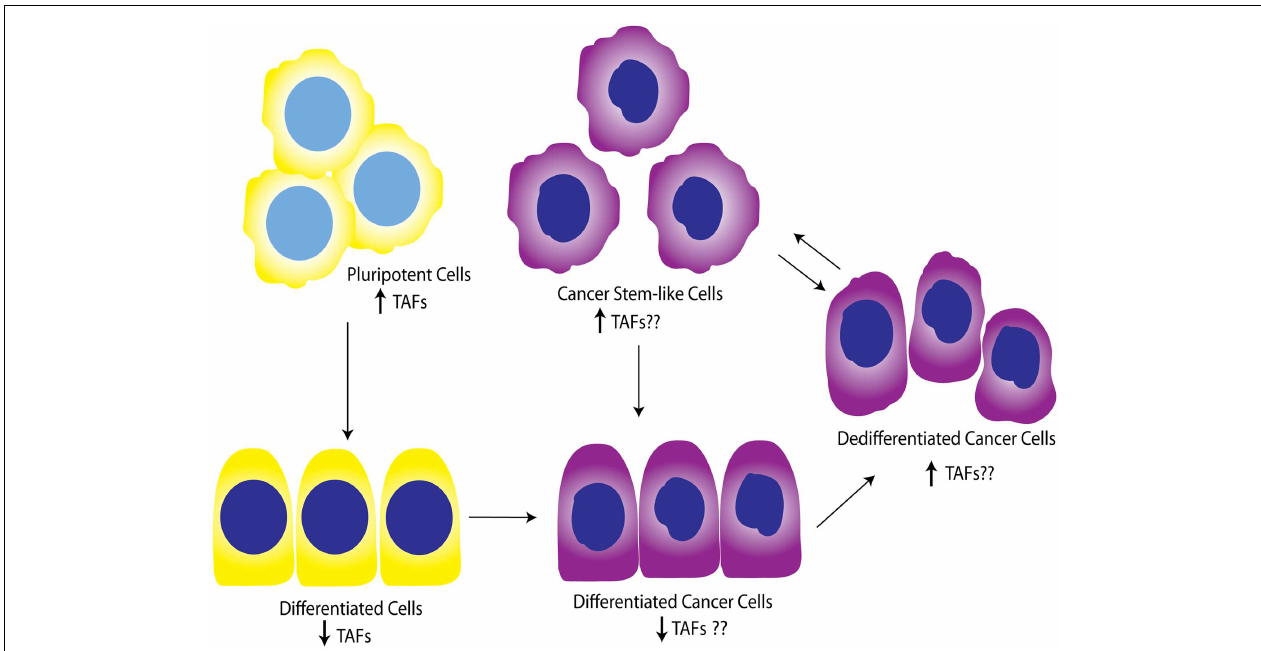
FIGURE 5 |Working model forTAF involvement in differentiation during development and tumor progression . Studies show thatTAFs are downregulated in differentiated cells compared to pluripotent cells.This model illustrates the hypothesis thatTAFs are also expressed at lower levels in differentiated cancer cells, but may be upregulated as these cells progress to dedifferentiated cells or pluripotent cancer stem-like cells.Yellow, normal cells; purple, cancer